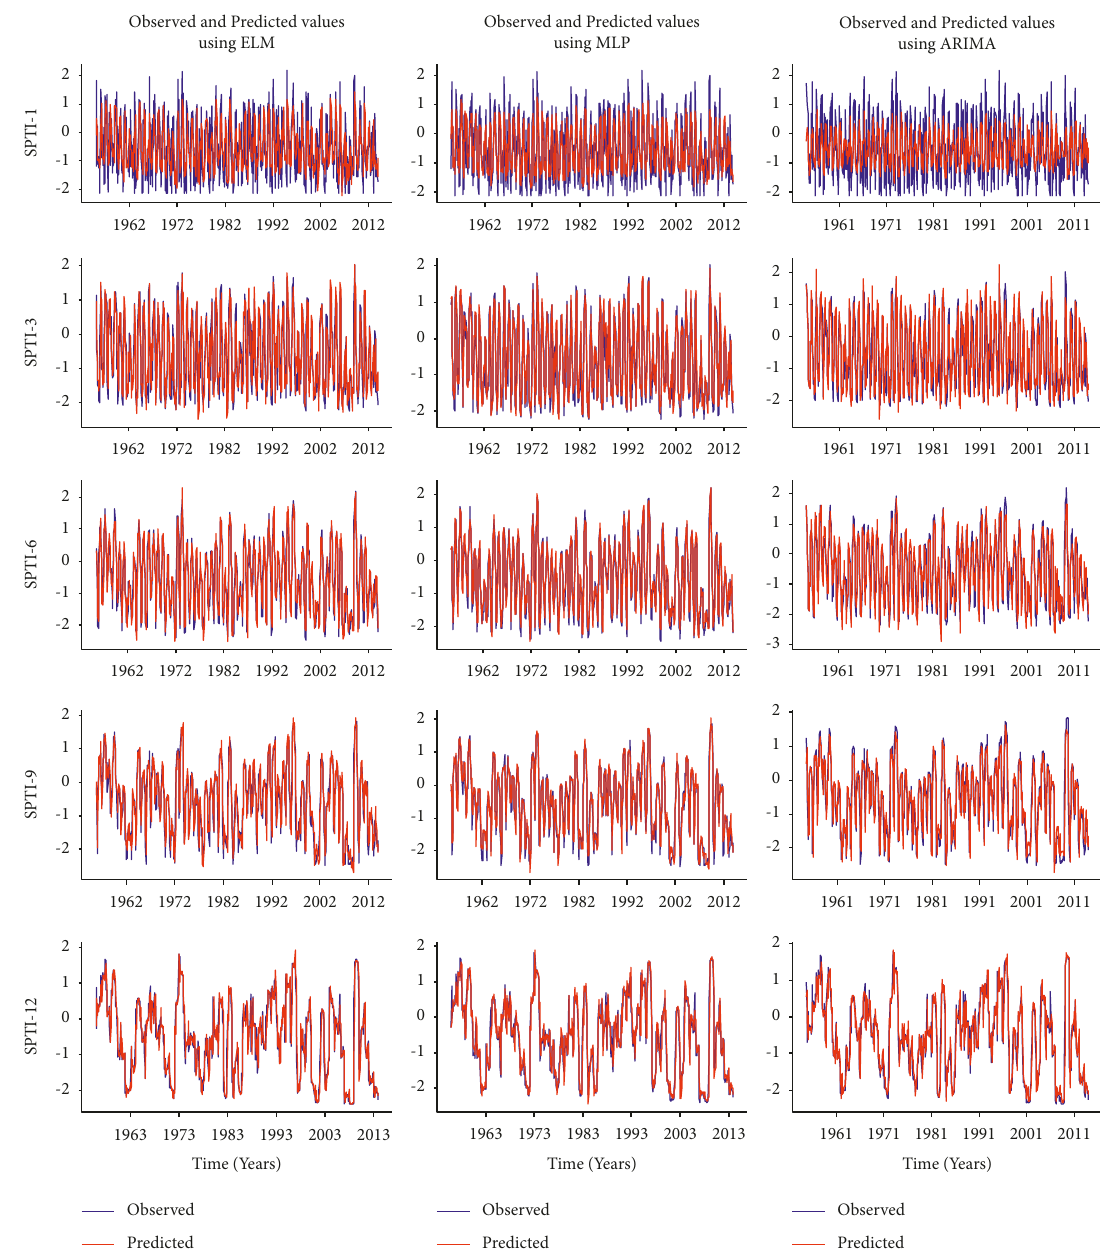
Figure 4: Performance assessment of ELM, MLP, and ARIMA models through co-movement of observed and predicted values of SPTI at Astore station for the training